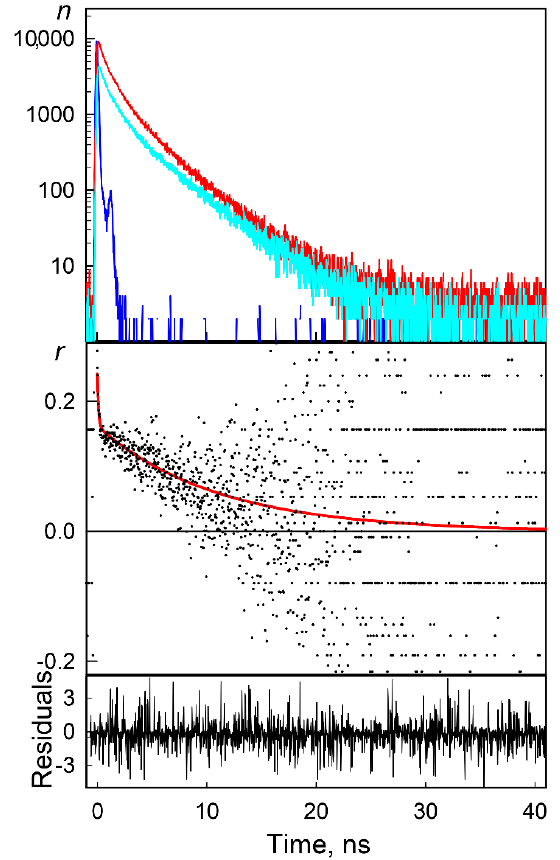
Figure 4. Time-resolved fluorescence anisotropy of BADAN linked to GGBP/H152C. The top panel represents the experimental decay curves of parallel (red curve) and perpendicular (cyan curve) components of the BADAN fluorescence; the instrument response function (blue curve) in semi-logarithmic scale. The middle panel represents time-resolved anisotropy decay calculated according to Equation (3) (dots) and the best fit (red curve); weighted residuals are shown at the bottom panel. Anisotropy decay curves were approximated by bi-exponential functions. This allows the separation of the ‘slow’ and ‘fast’ BADAN motions and the calculation of the mean amplitude of dye high frequency mobility, θ . It was shown that the intramolecular mobility of BADAN is restricted by the complex formation of GGBP/H152C with glucose. Sufficient restriction of the dye internal motion also was observed in solutions with GdnHCl sub-denaturing concentrations for glucose-bound GGBP/H152C (Table 1). The most noticeable effect was found for the GGBP/H152C holo-form in the solution of 0.5 M GdnHCl (Table 1). These data supported our hypothesis that the increase in the fluorescence intensity of BADAN linked to the GGBP/H152C holo-form in solutions with sub-denaturing GdnHCl concentrations is caused by the increase in the rigidity of the BADAN local environment.